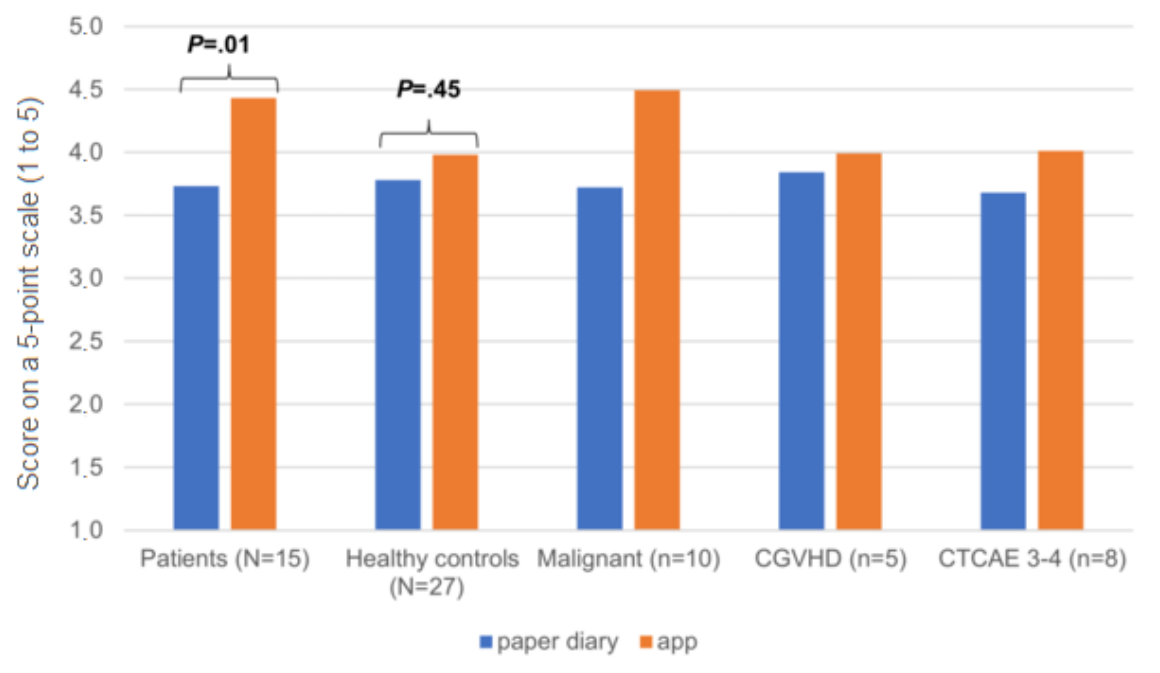
Figure 3. Comparison of the paper diary with the mobile app. The plot shows the clinician-reviewed quality of medical information regarding patient-reported health status on a 5-point scale, ranging from 1 (low) to 5 (high). Malignant refers to malignant underlying disease. cGVHD: chronic graft-versus-host disease; CTCAE 3-4: National Cancer Institute (NCI) Common Terminology Criteria for Adverse Events (CTCAE) grade of